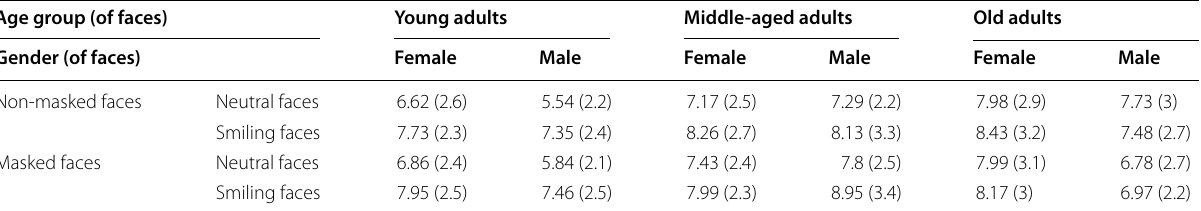
Table 1 Mean accuracy (absolute errors in years) of age evaluations in Experiment 1 (standard deviations in brackets). Note that larger numbers indicate lower accuracy Age group (of faces) Young adults Middle‑aged adults Old adults Gender (of faces)